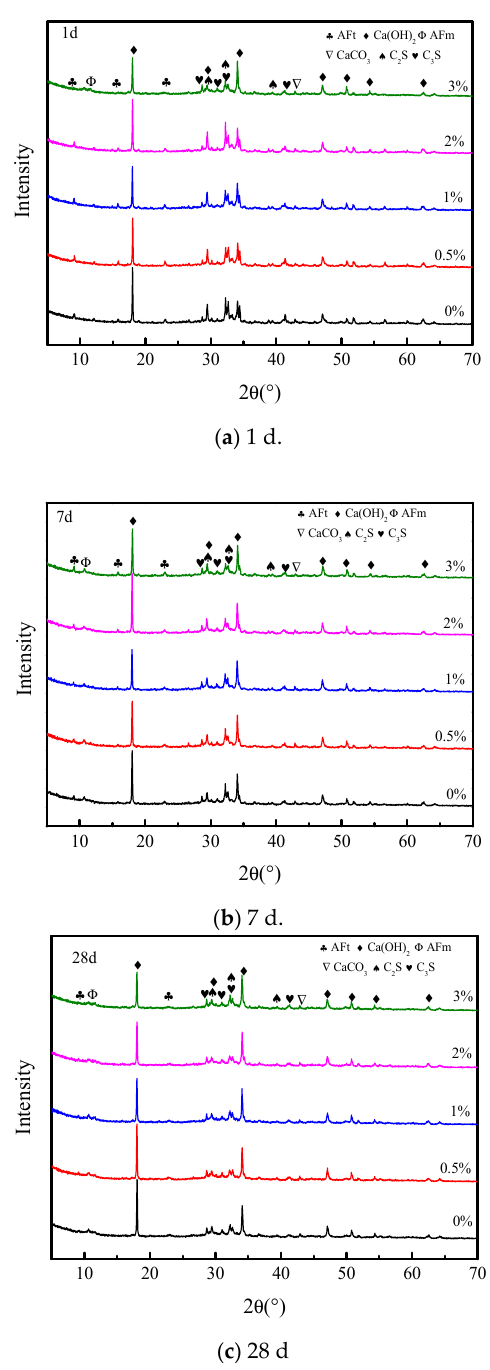
Figure 7. XRD powder di ff raction patterns of the sample with di ff erent contents of nano C-S-H particles at the age of 1, 7, and 28 days.